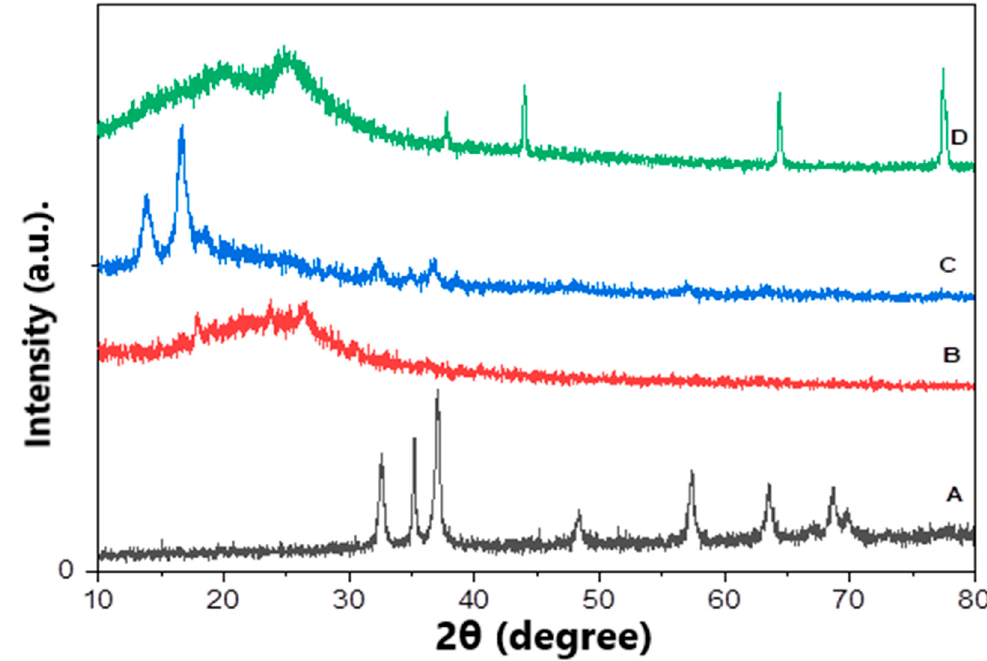
Figure 3. XRD patterns of various prepared matrices, ( A ) ZnO NPs, ( B ) Ppy NPs, ( C ) ZnO polymeric composite nanofibers and ( D ) ZnO polymeric composite nanofibers after silver immobilization.